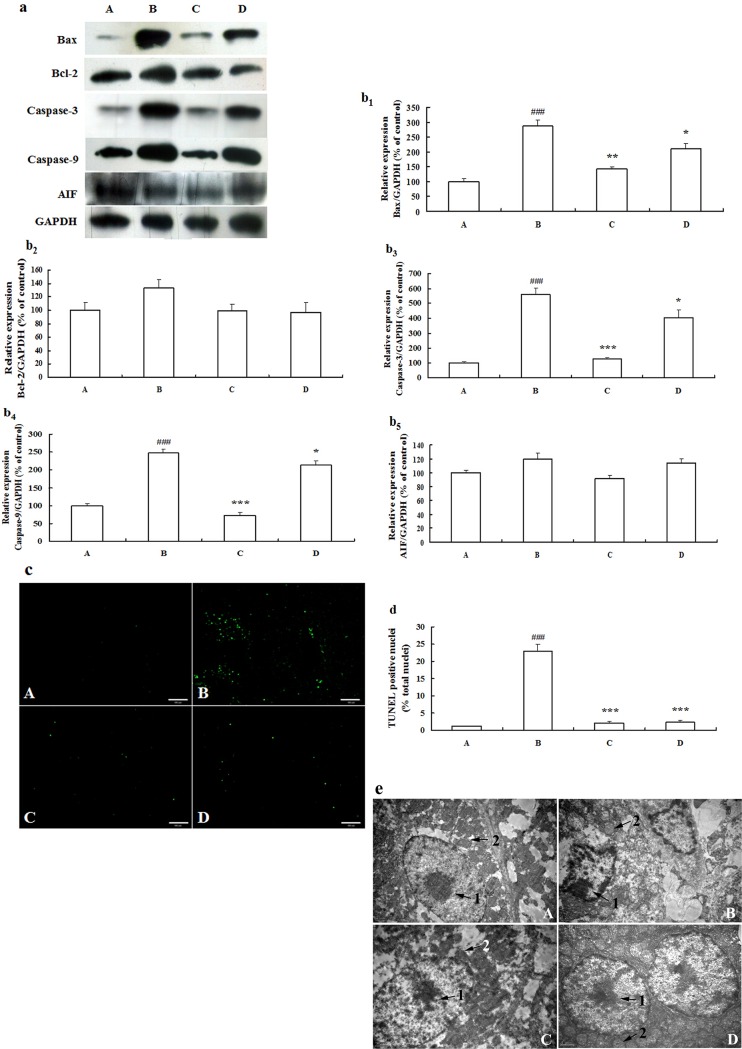
Effects of ZYC-1 on apoptotic index in the liver of rats treated with DMN.(a) Protein expression levels of Bax, Bcl-2, Caspase-3, Caspase-9 and AIF was detected by Western blot, and the gels have been run under the same experimental conditions. Cropped blots are used in (a), and full-length blots are presented in supporting information (S5 Fig). (b1-5) Densitometry analysis is presented as the relative ratio of protein (Bax, Bcl-2, Caspase-3, Caspase-9 and AIF)/GAPDH using Quantity One software. (c) The TUNEL assay was observed under fluorescence microscopy. Bar = 100 μm. (d) Statistic analysis of TUNEL was evaluated by fluorescence intensity using Image Pro Plus 6.0 software. (e) TEM observation of liver apoptosis. The morphological alternations of nuclei (1) and mitochondria (2) (as arrows showed) indicated in TEM images. A: normal group; B: DMN model group; C: ZYC-1 treatment group; D: IFN-α2b treatment group. Bar = 1 μm. Data represent the mean ± S.D. ###P < 0.001 vs. normal group, *P < 0.05, **P < 0.01, ***P < 0.001 vs. DMN model group.